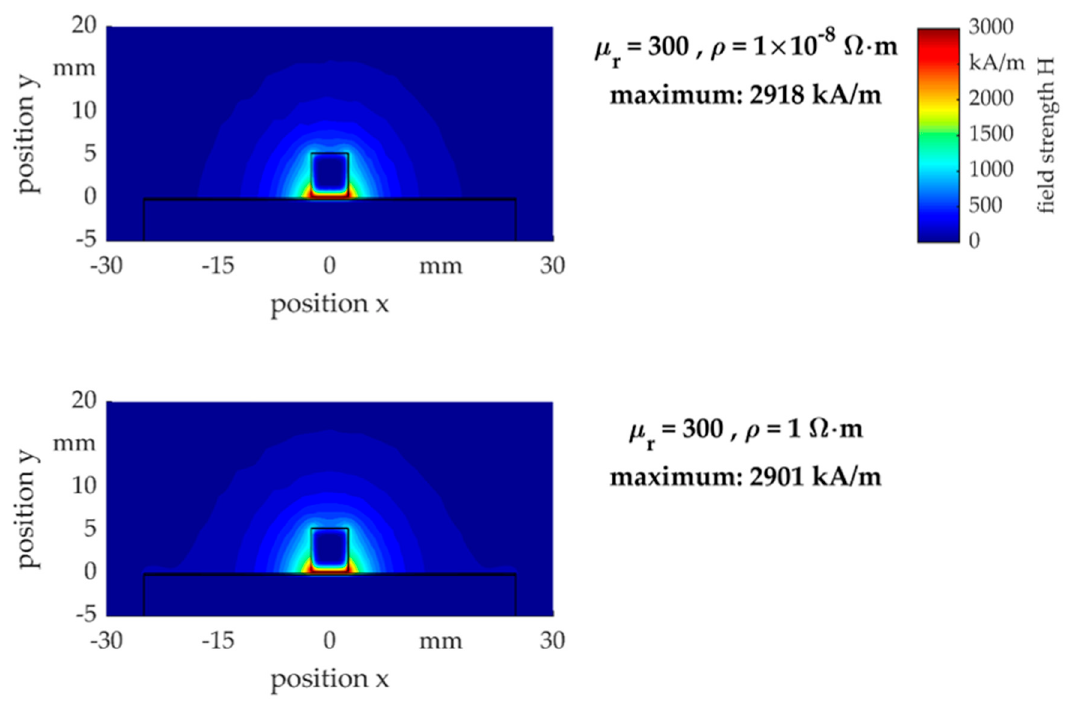
Figure 10. Distribution of the magnetic field with high relative permeability µ r of the die during the maximum current density in the tool coil.